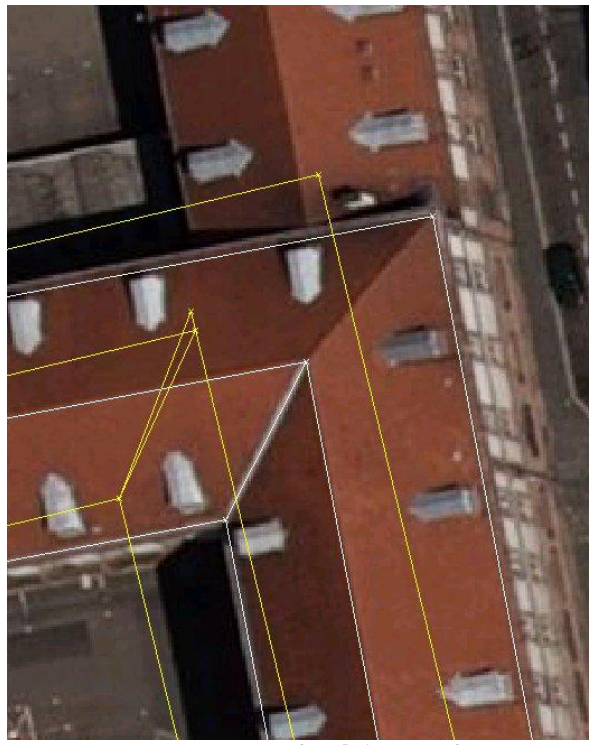
Figure 7. Zoom view of circled region of Fig. 6 In this experiment, only one image (Fig. 6) is used. In order to reinforce the effectiveness of proposed method, the optimized model is also back projected to another image (Fig. 8), which covers this building but is not used during the reconstruction procedure. The optimized polygons fit the real building’s edges very well too.